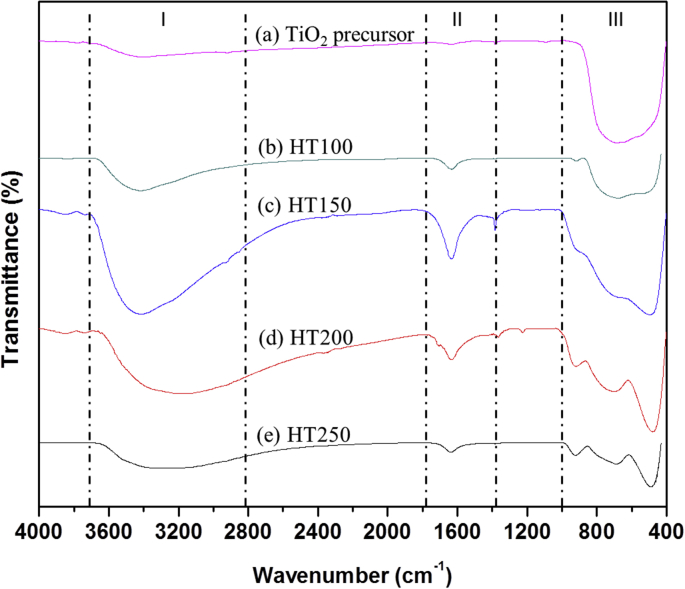
FTIR spectra of (a) TiO2 precursor, (b) HT100, (c) HT150, (d) HT200, and (e) HT250.